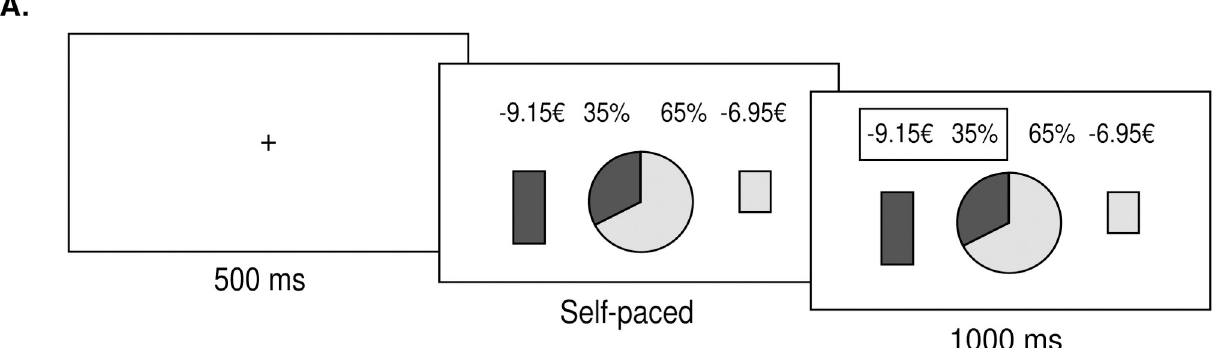
Fig 4. Experiment. A. Behavioral task. Successive screenshots displayed during a given trial are illustrated from left to right, with durations in milliseconds. At each trial, following a short fixation (500ms), subjects have to choose between a risky (here, left: 35% chance to lose 9.15 € ) and a safe (here, right: 65% chance to lose 6.95 € ) lottery. Choices are self-paced, and followed by a choice-confirmation screen, where the selected lottery is highlighted by a contour box.